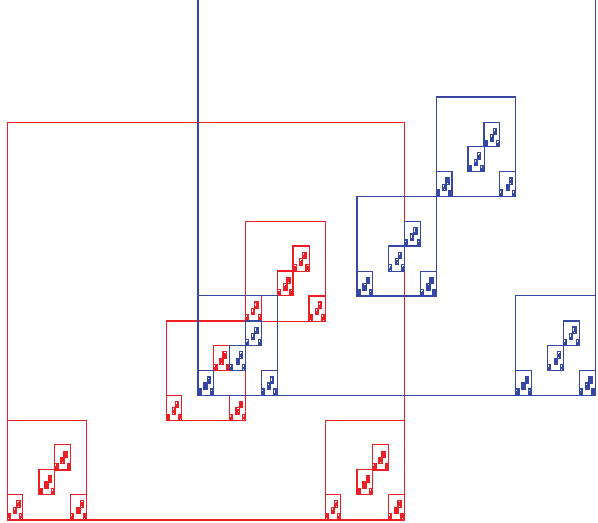
Figure 2: Construction of 𝐾∩𝐾+𝑡 . Red and blue rectangles denote the construction of 𝐾 and 𝐾 + 𝑡 ,